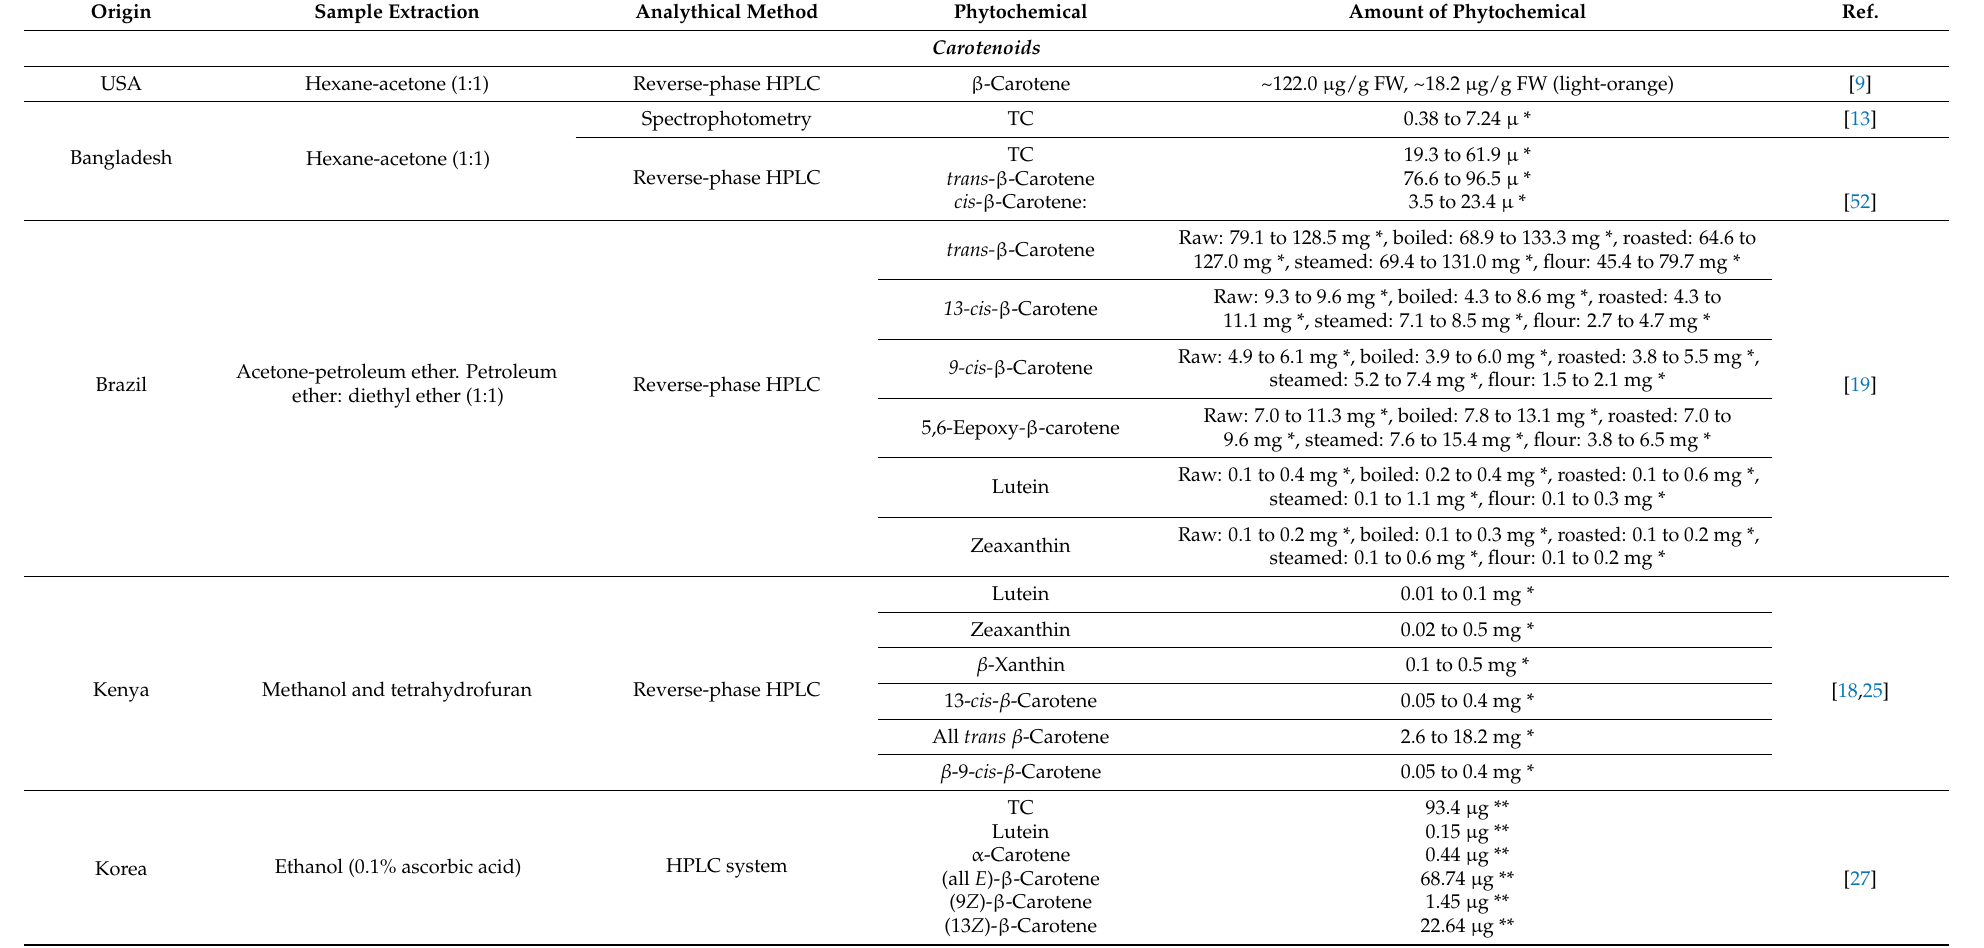
Table 4. Carotenoid, phytosterol, and other phytochemical contents of orange sweet potato